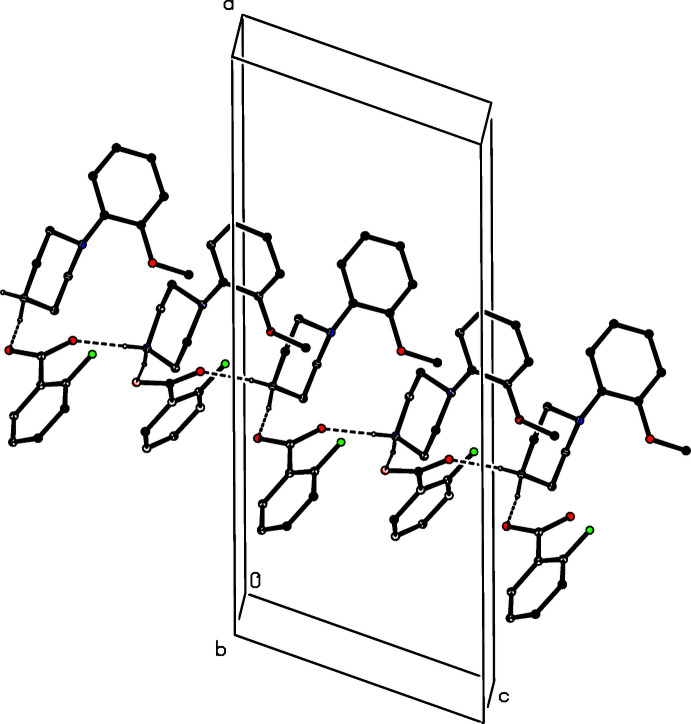
Part of the crystal structure of compound (IV) showing the linking of the ion pairs by a further N—H⋯O hydrogen bond to form a (6) chain running parallel to [001]. Hydrogen bonds are drawn as dashed lines and, for the sake of clarity, the minor disorder component and the H atoms bonded to C atoms have been omitted.